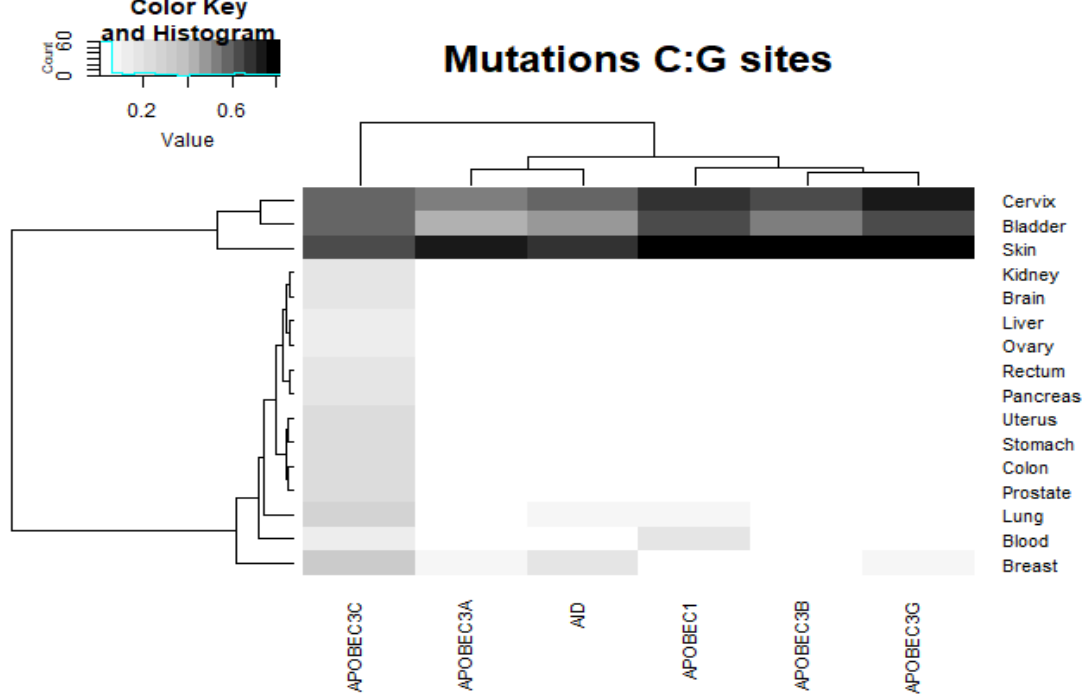
Figure 6. Fraction of random matrices with a significant correlation between AID/APOBEC pseudo-mutable motifs (randomly sampled sites from the yeast genome) and the sequence context of somatic mutations in C:G sites. For the actual data, see Supplementary Table S2. The intensities of the gray color correspond to the fractions of cases with a significant correlation between pseudo-mutable motifs (represented as weight matrices) and the context of somatic mutations in C:G sites.